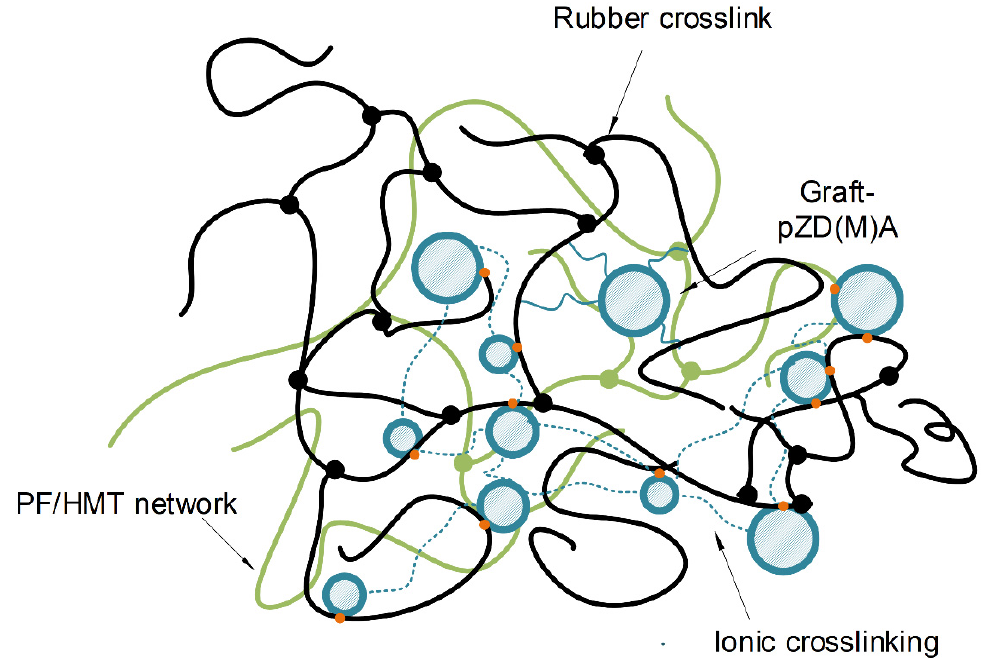
Figure 5. The proposed network structure of an ionic hybrid filler system.